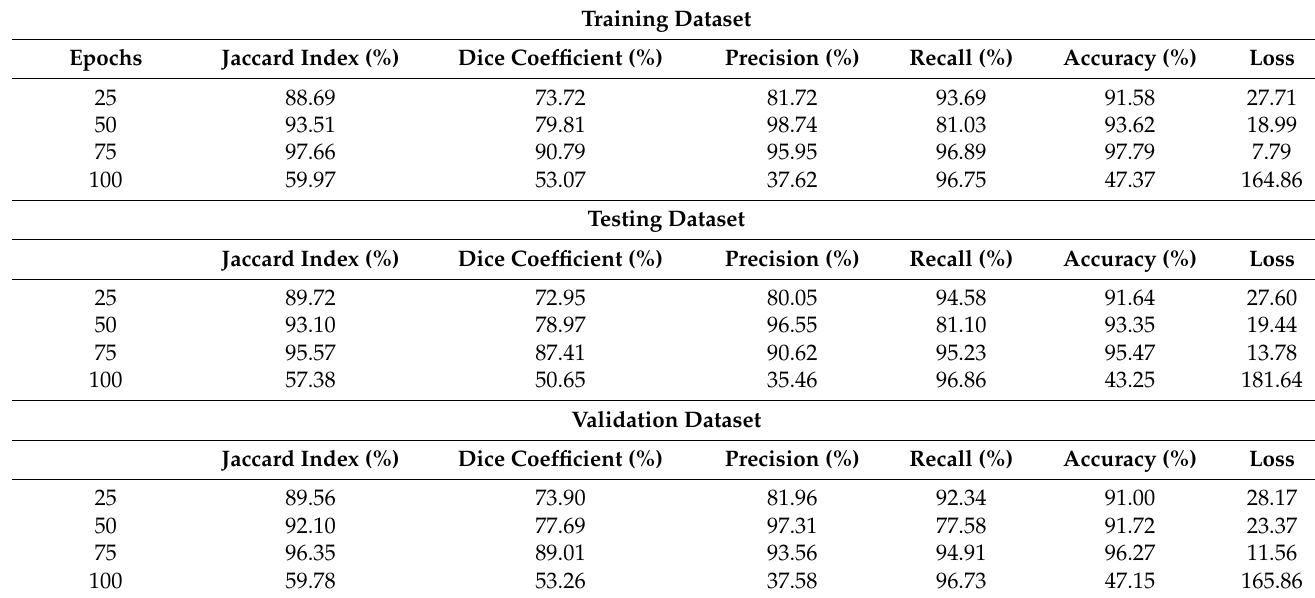
Table 4. Analysis of different epochs using the Adam optimizer and batch size 8.